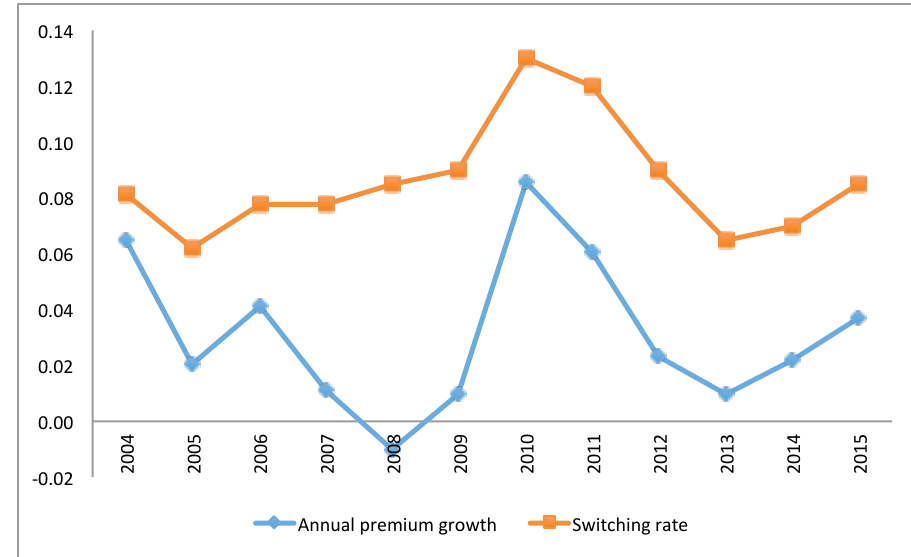
Figure 8. Switching rates and annual premium growth from 2004 to